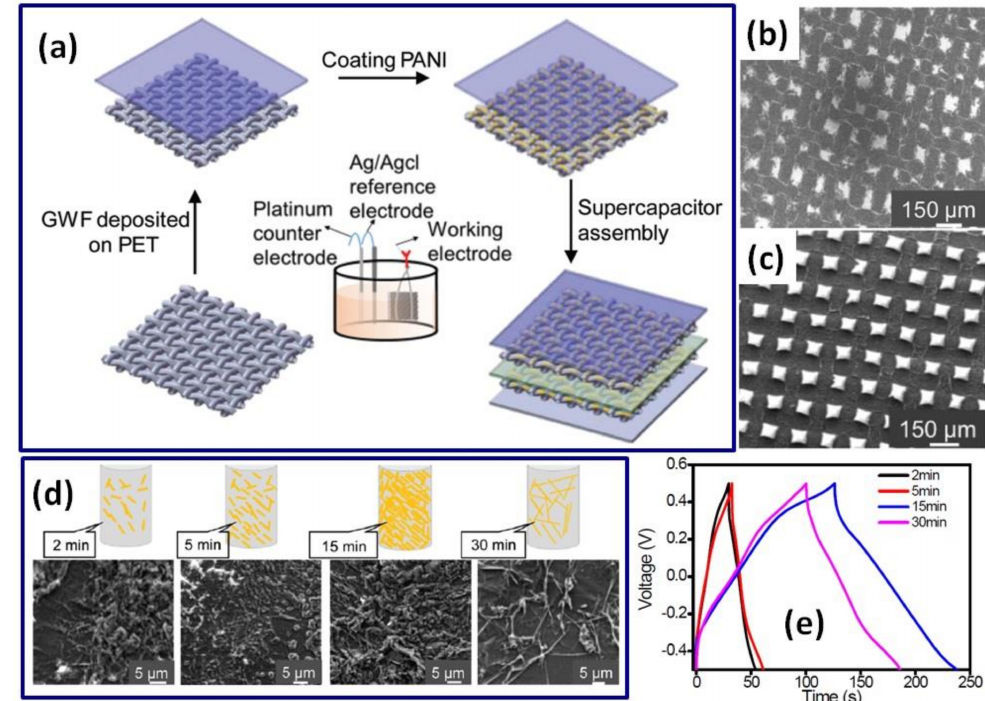
Figure 16. Illustration of the preparation and fabrication process for the GWF with PANI super- capacitor ( a ). Microstructures of GWF ( b ) and GWF +PANI films ( c ). Schematic illustrations and microstructures of the GWFs coated with PANI at different electropolymerization times (2, 5, 15 and 30 min, respectively) ( d ). Galvanostatic charge/discharge curves of GWF+PANI (Current density: 0.1 mA/cm 2 ) ( e ) (Reprinted from [52] with permission of RSC